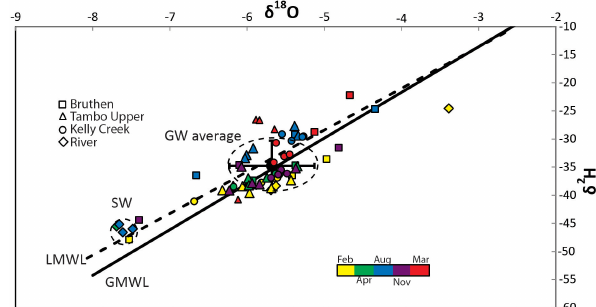
Figure 4. δ 18 O and δ 2 H values of bank water and river water from the Tambo River. LMWL defined by Melbourne meteoric water line in Hughes and Crawford (2012). Dashed lines indicate typical river water and bank water